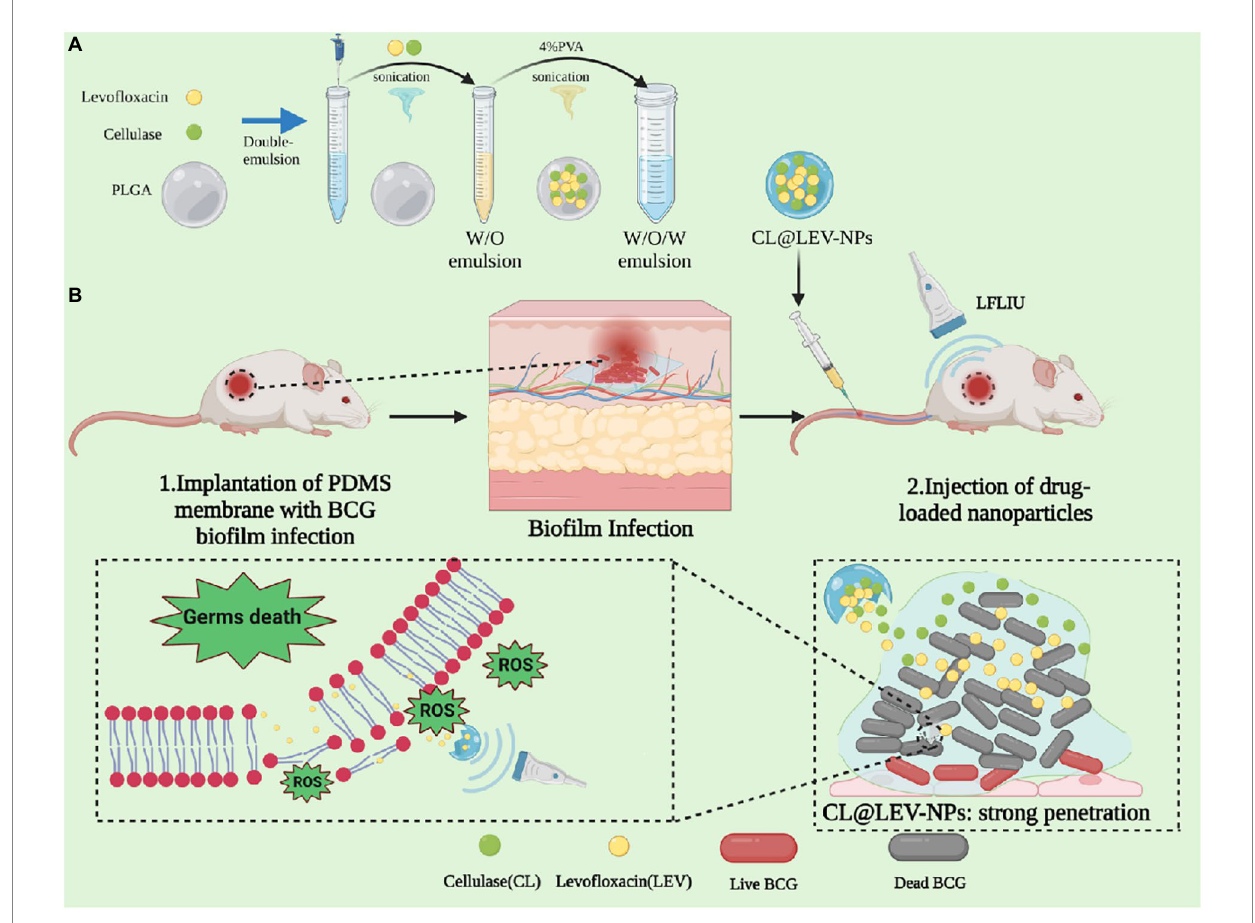
FIGURE 1 Schematic diagram of biofilm dispase combined with antibiotic composite nanoparticles for sonodynamic antimicrobial chemotherapy of BCG biofilm